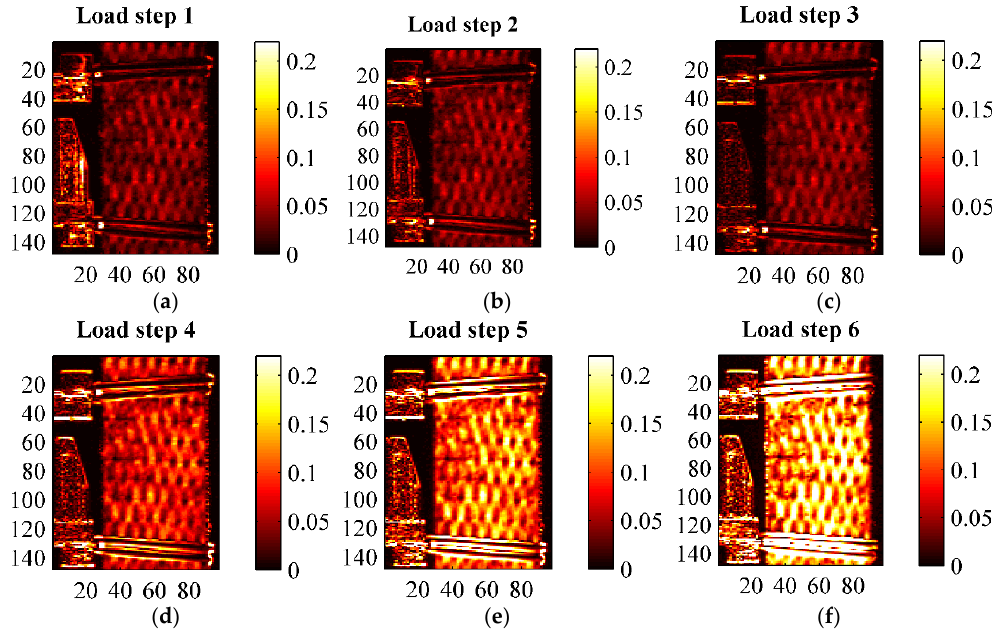
Figure 13. Thermoelastic signal amplitude Δ T in (°C) from a VB sample at the various loading steps.